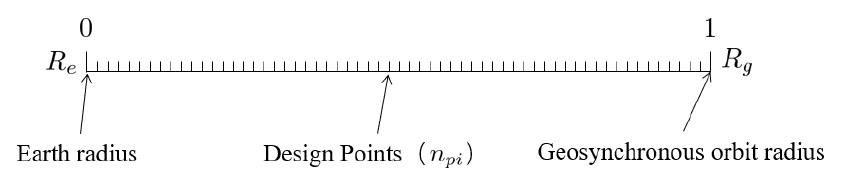
Figure 8. Design grid between the equatorial radius and the radius of geosynchronous